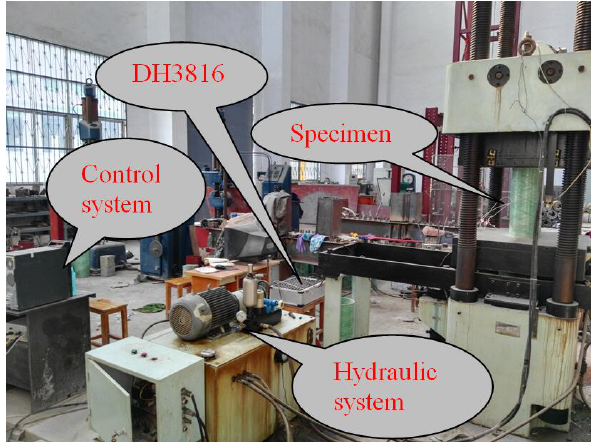
Figure 6: Loading system